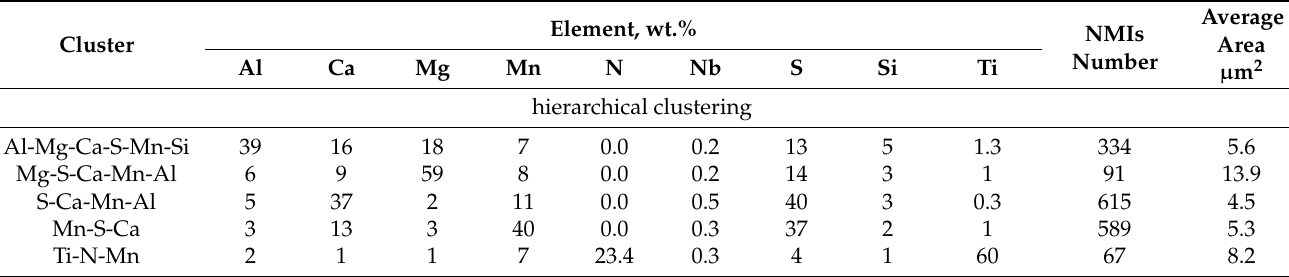
Table A3. Results of clustering by different methods in steel